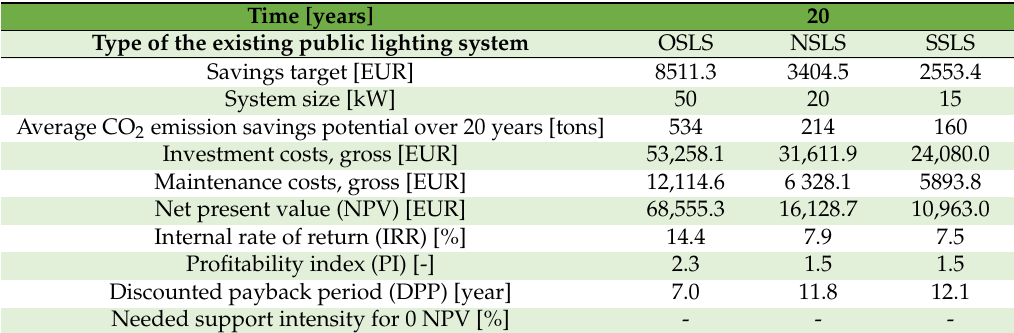
Table 3. 50, 20, 15 kW PV investments for offsetting electricity consumption costs of street lighting systems. Time [years]